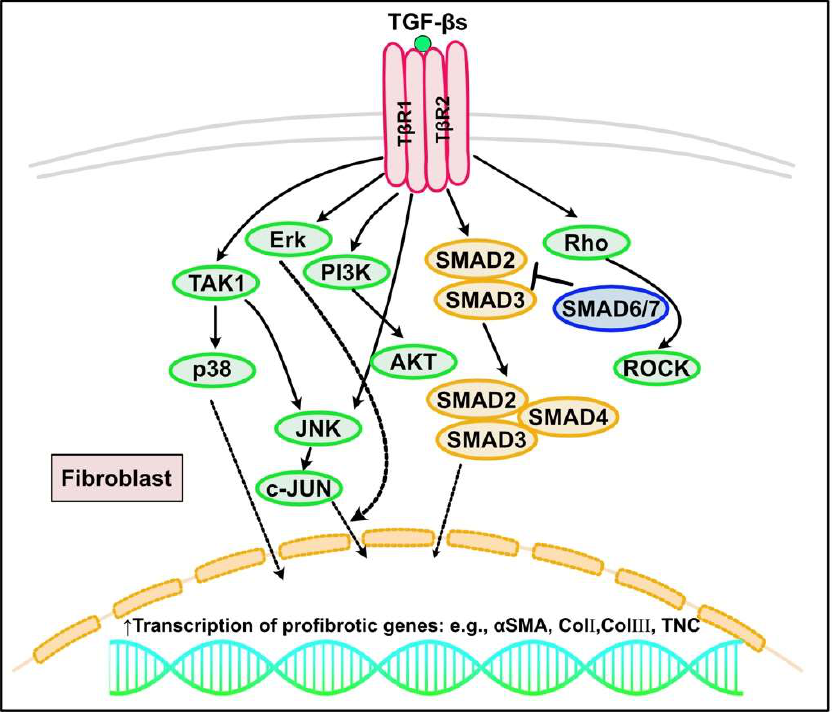
Figure 3. TGF- β signaling in cardiac fibrosis. TGF- β could induce the signal transduction via the canonical (SMAD-dependent) and non-canonical (SMAD-independent) pathways. In the canonical pathway, TGF-β1 binds to and causes heterodimerization of TGF-β receptor type 1 (TβRI, also known as activin-like kinase (ALK) 5) and the type II receptor (T β RII), leading to the phosphorylation of SMAD2/SMAD3, which subsequently form a complex with SMAD4 and translocate into the nucleus, acting as a transcriptional factor to regulate the fibrotic gene expression (e.g., α SMA, collagen I, III or TNC). SMAD6/7 are inhibitory SMADs to inhibit transcription of SMAD2 and SMAD3. In canonical pathways, TGF- β 1 can also induce SMAD-independent noncanonical signaling that involves several mitogen-activated protein kinases, including extracellular signal-regulated kinase (Erk), c-Jun-N-terminal kinase (JNK), TGF-β-activated kinase 1 (TAK1), Rho family of small GTPase, and p38 MAPK pathways.